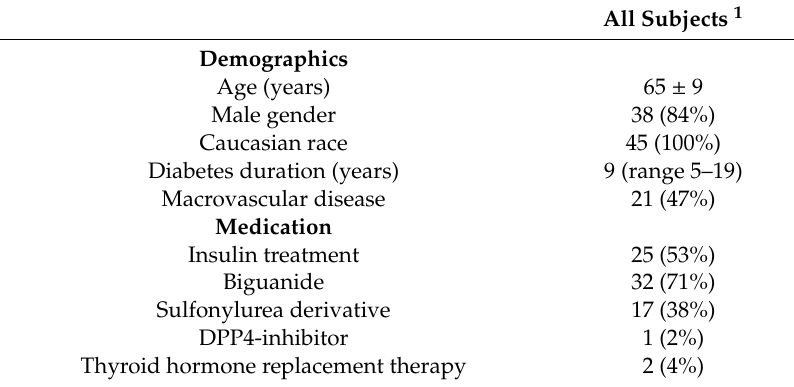
Table 1. Baseline characteristics of the study subjects ( n =